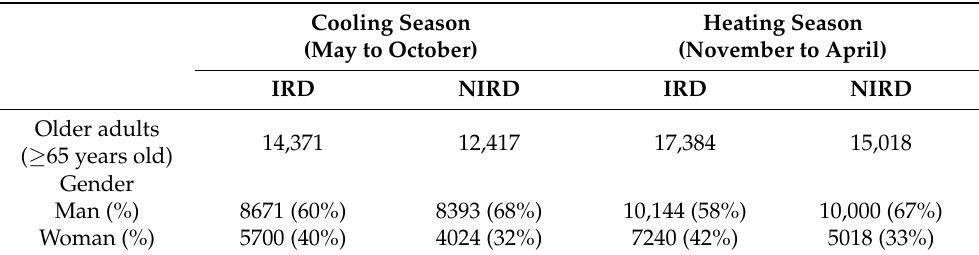
Table 2. Summary of respiratory disease-related emergency department visits (proportion) from 2006 to 2014 in different seasons.